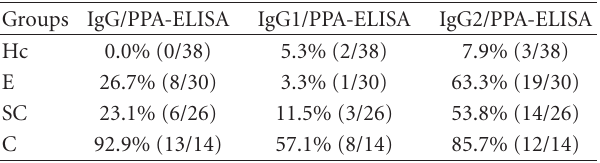
Numbers of positive animals are shown between brackets. Groups: healthy controls (Hc, n = 38), exposed (E, n = 30), subclinically infected (SC, n = 26), and clinically infected (C, n =